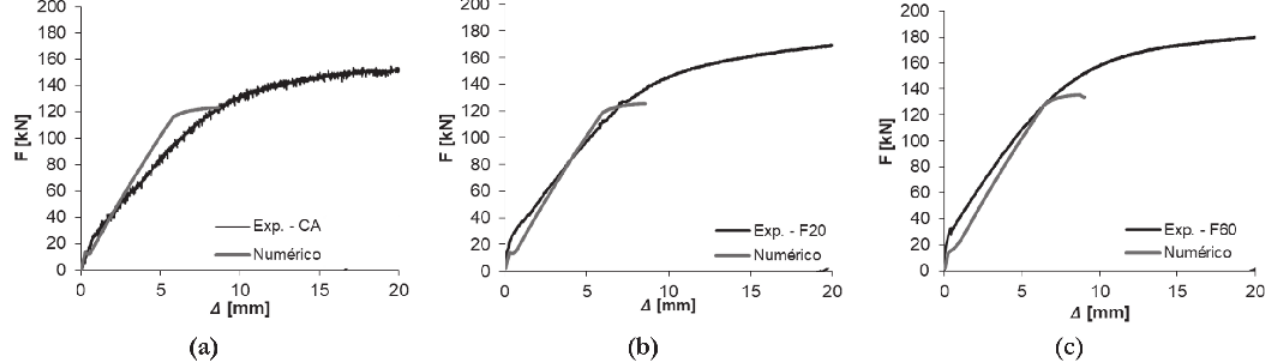
Comparação dos resultados da análise seccional com os valores experimentais: a) sem